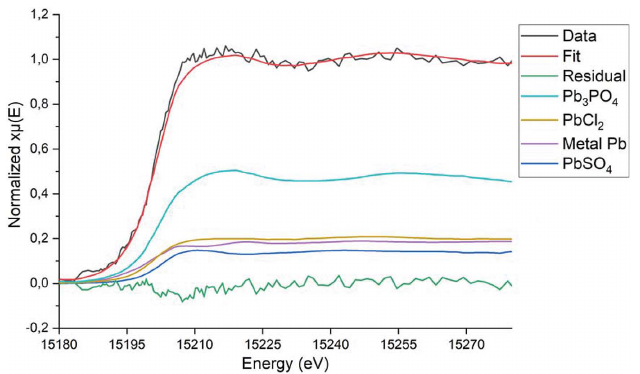
Figure 4 A fit obtained through LCF analysis of the Pb L 2 -edge merged spectrum of the H samples, using Pb metal foil, PbCl 2 , PbSO 4 and Pb 3 PO 4 spectra as standard references [last three taken from Lanzirotti et al. (2014), extracted using the free online tool WebPlotDigitizer (Rohatgi,